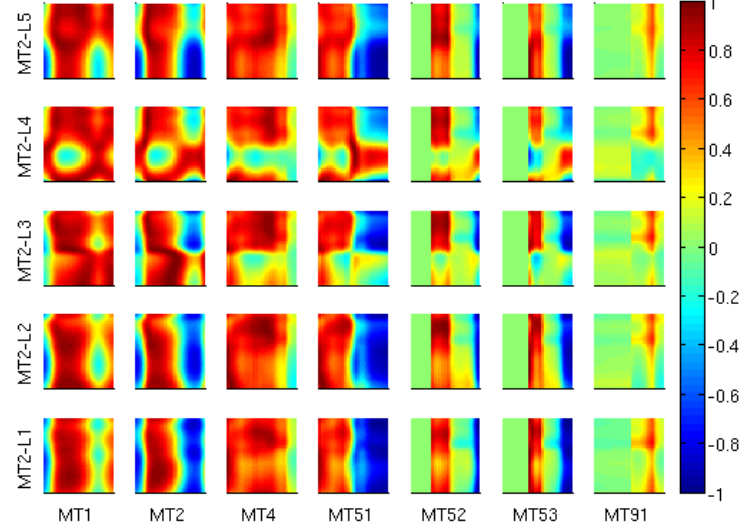
Figure 3. Correlation matrices between cross sections and Legendre coefficients of elastic scattering